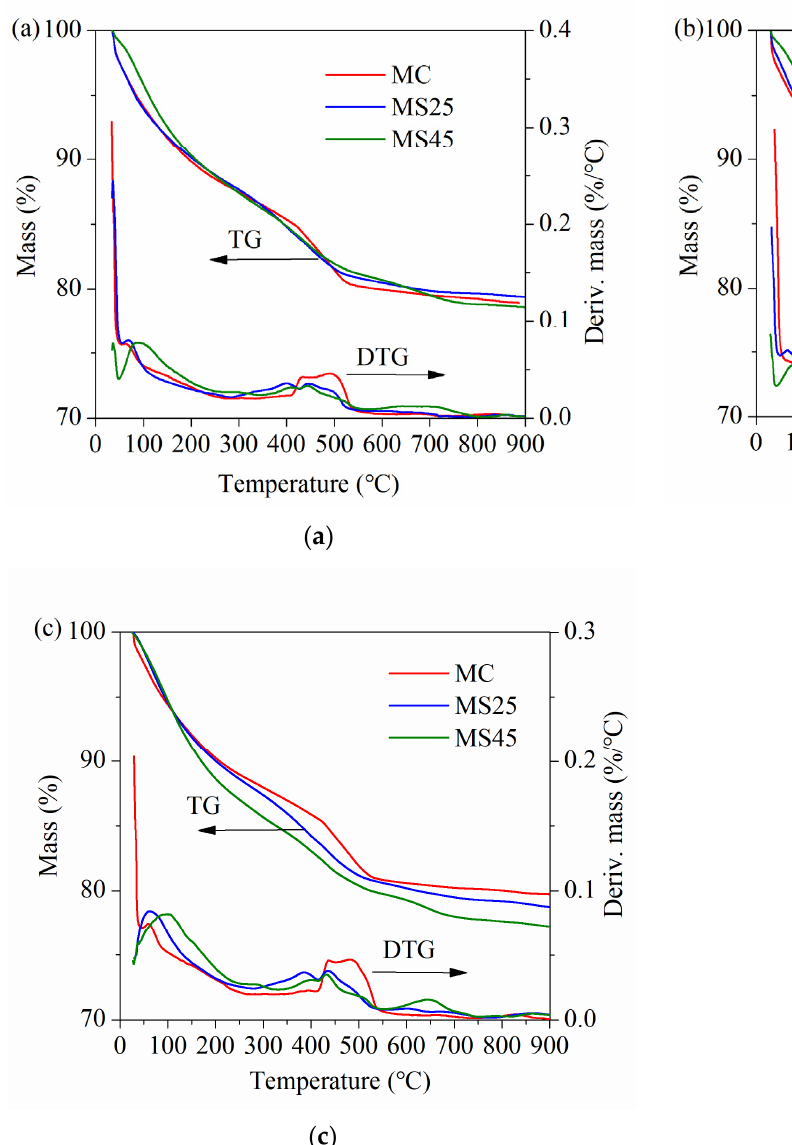
Figure 12. TG and DTG curves of hardened pastes under temperature-matching curing conditions: ( a ) at 14 d; ( b ) at 28 d; ( c ) at 90 d.